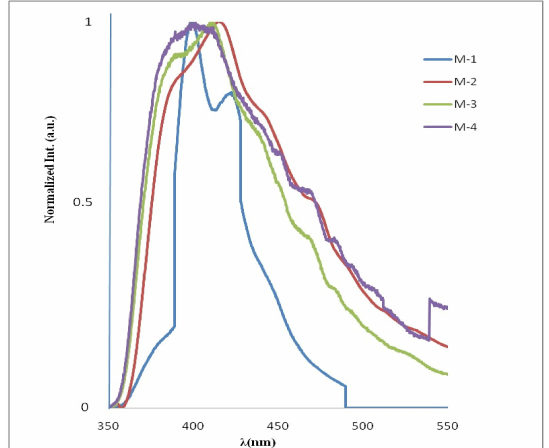
Figure 5: Photoluminescence spectra of ZnSe/PVA with varying Zn 2+